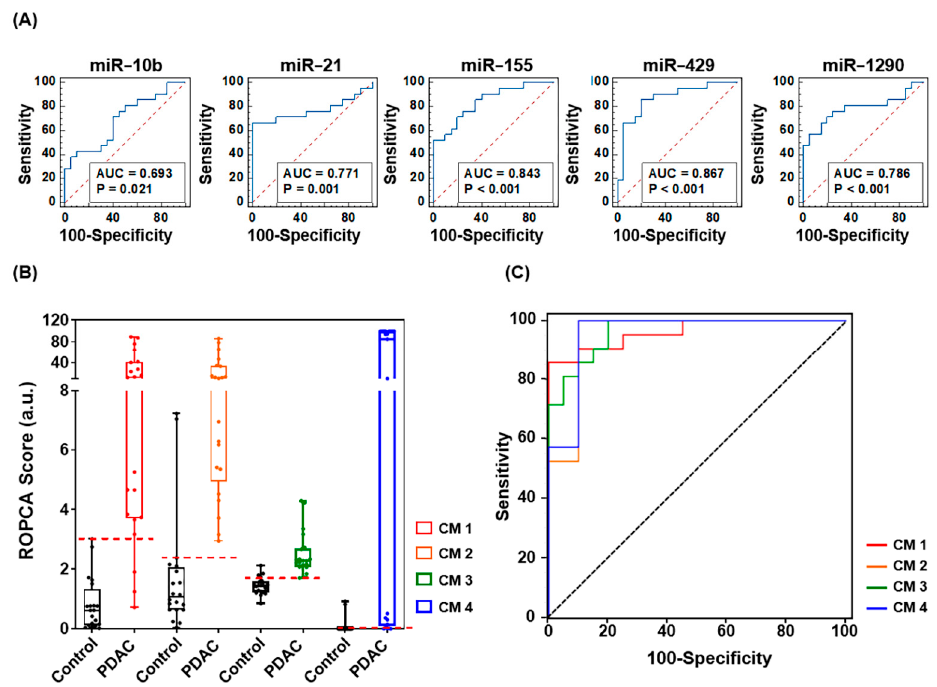
Figure 7. ( A ) ROC curve analyses of the abilities of five candidate miRNAs to discriminate PDAC patients from normal controls. ( B ) ROPCA scoring of CMs 1–4. CM 1 consisted of miR-21, miR-155, miR-429, miR-1290, and CA19-9. CM 2 consisted of miR-10b, miR-21, miR-155, miR-1290, and CA19-9. CM 3 consisted of miR-10b, miR-155, miR-429, miR-1290, and CA19-9. CM 4 consisted of miR-10b, miR-21, miR-155, miR-429, miR-1290, and CA19-9. ( C ) ROC curve analyses of CMs 1–4.